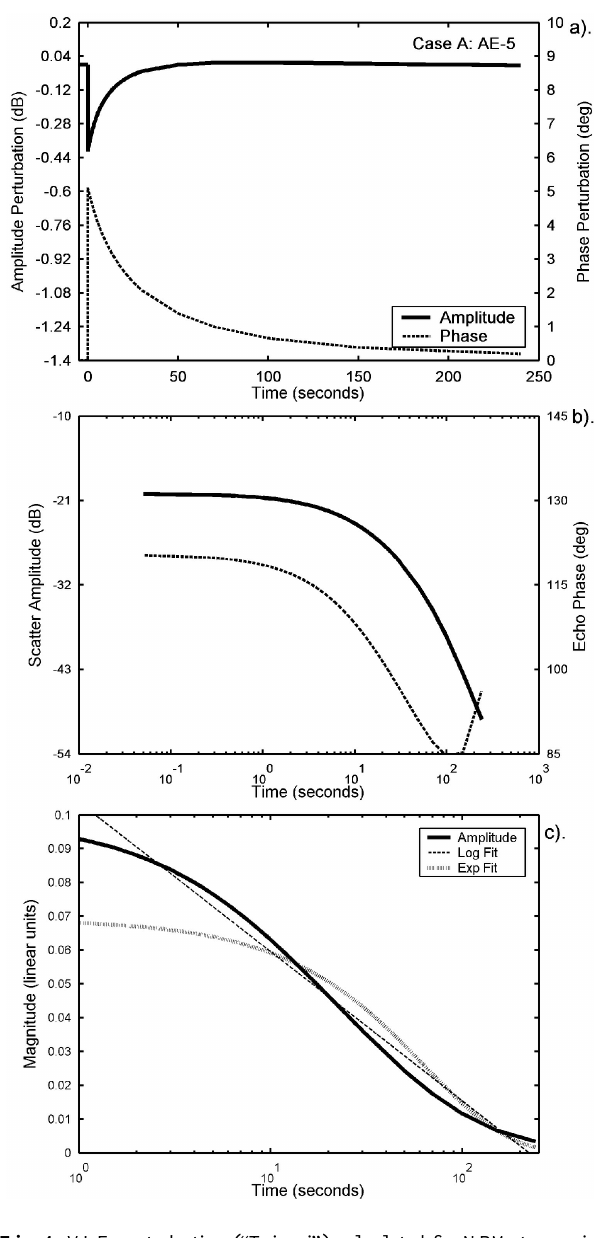
Fig. 4. VLF perturbation (“Trimpi”) calculated for NPM transmis- sions received at Faraday due to an ionospheric perturbation caused by a WEP burst with AE-5 energy spectra (case A) The top panel shows the perturbations in amplitude and phase, while the middle panel shows the calculated scatter magnitude and phase which pro- duces this Trimpi. The lower panel shows the decaying scatter mag- nitude plotted on a logarithmic timescale after Dowden et al. (2001), with logarithmic (dashed) and exponential (dash-dot)